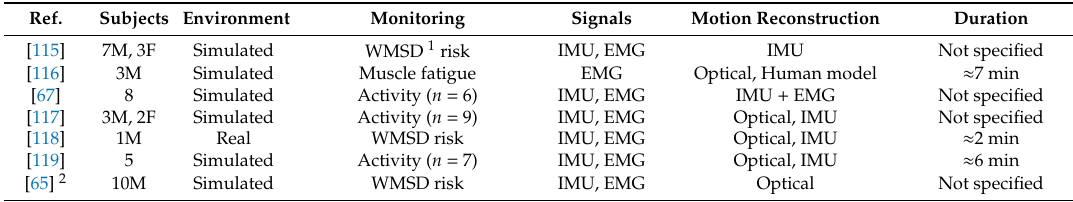
Table 5. Overview of EMG monitoring experimental setups in production engineering.